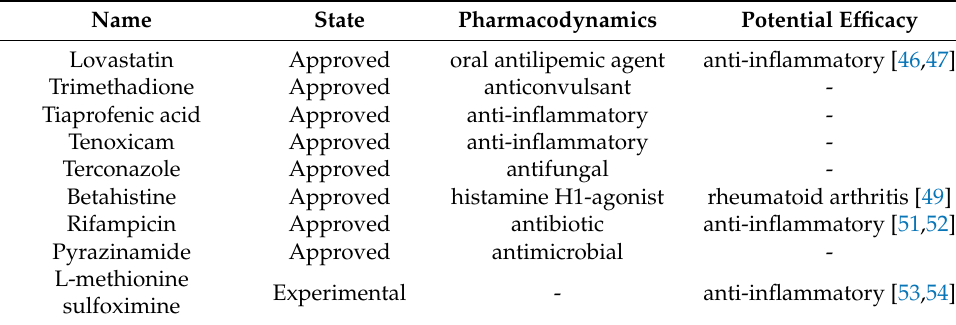
Table 2. The agent information of group